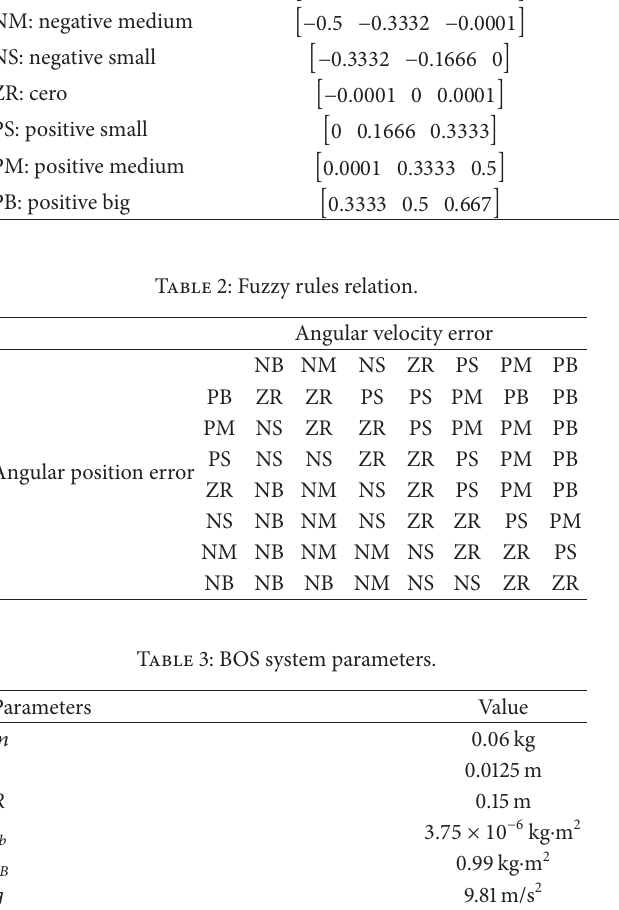
Figure 7: Fuzzy controller law.